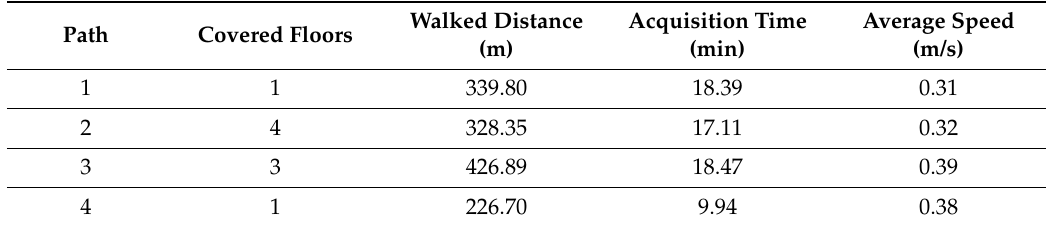
Table 2. General information about the WMLS paths.